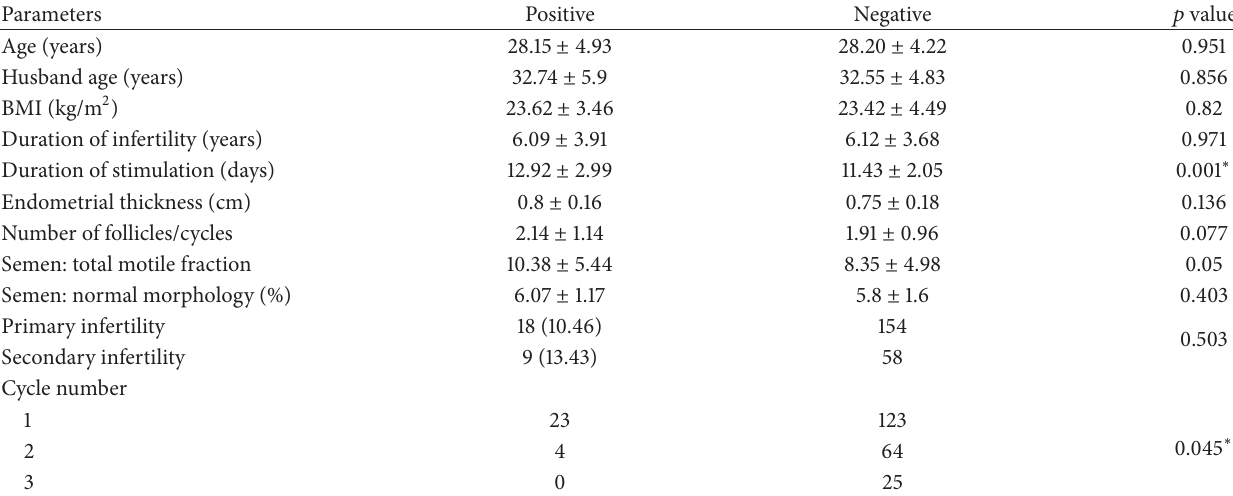
Table 1: Descriptive variables for 239 IUI